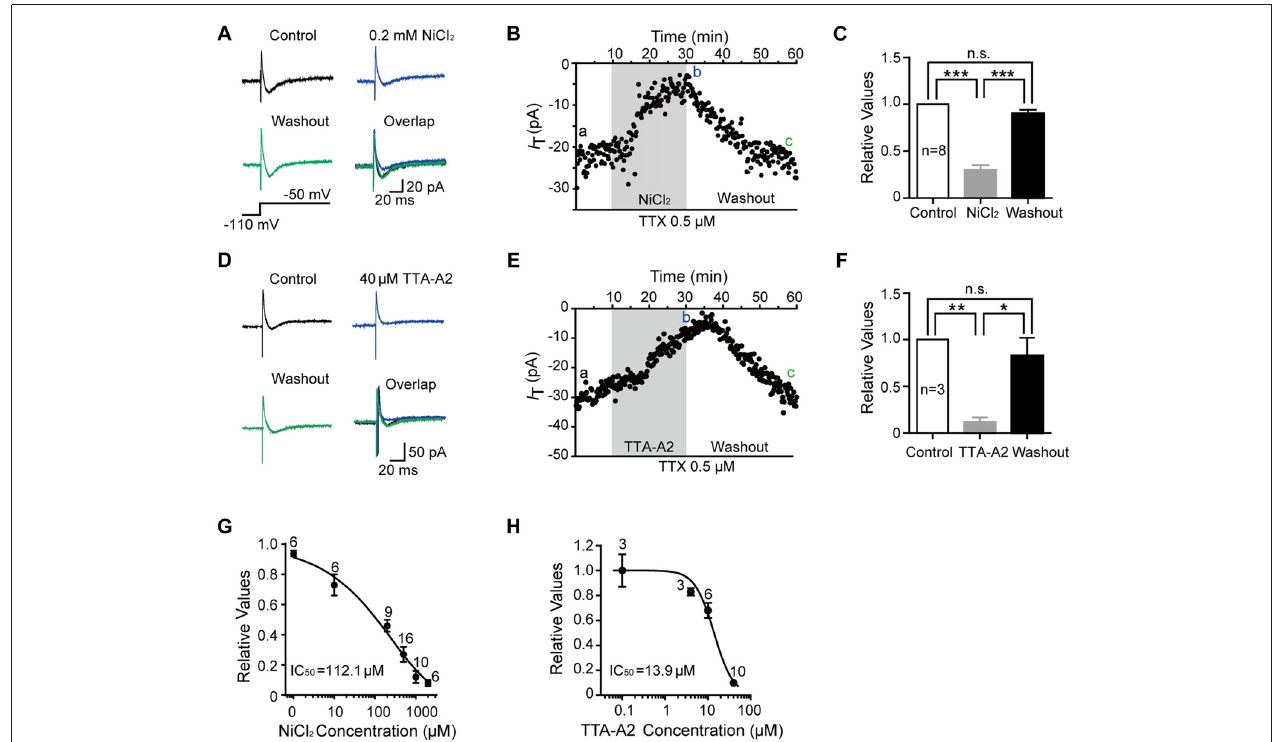
FIGURE 2 | Pharmacological properties of T-type current in SG neurons. (A) Representative traces of T-type current in control, with 0.2 mM NiCl 2 , after washout of NiCl 2 , and the superimposed traces. In this figure, all the T-type current was activated every 10 s by a 200-ms voltage step to − 50 mV from a holding potential of − 110 mV for 500 ms (inset). (B) Time course of a representative experiment during application of NiCl 2 that shown in panel (A) . The amplitude of T-type current is depicted over time. (C) Summary of the blockade of T-type current by NiCl 2 . (D) Representative traces of T-type current in control, with 40 µ M TTA-A2, after washout of TTA-A2, and the superimposed traces. (E) Time course of a representative experiment during application of TTA-A2 that shown in panel (D) . The amplitude of T-type current is depicted over time. (F) Summary of the blockade of T-type current by TTA-A2. (G,H) Concentration-response relationship for NiCl 2 and TTA-A2. Concentration-response curve was fitted with the Hill equation as follows: y = I max /(1 + IC 50 /x), in which I max represents the maximal current amplitude, IC 50 is the half-maximal inhibitory concentration, and x is the concentration. ∗ P < 0.05, ∗∗ P < 0.01, ∗∗∗ P < 0.001, ns, not significant.